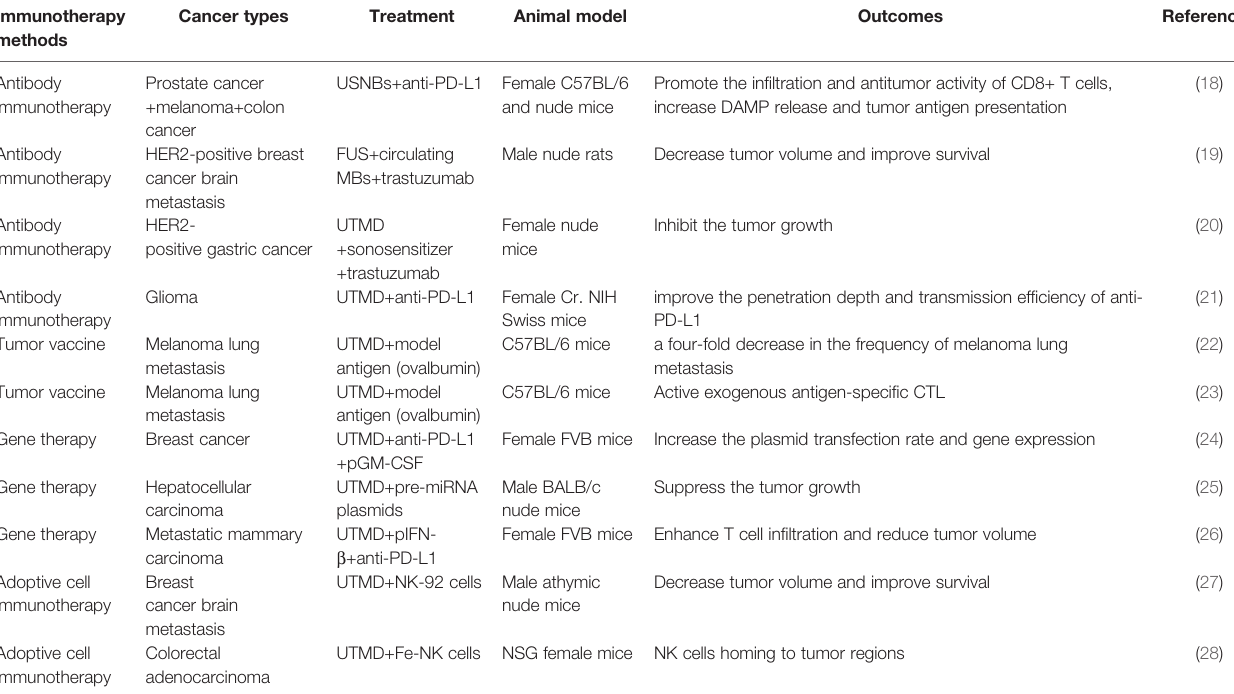
TABLE 1 | Application of UTMD combined with immunotherapy in various